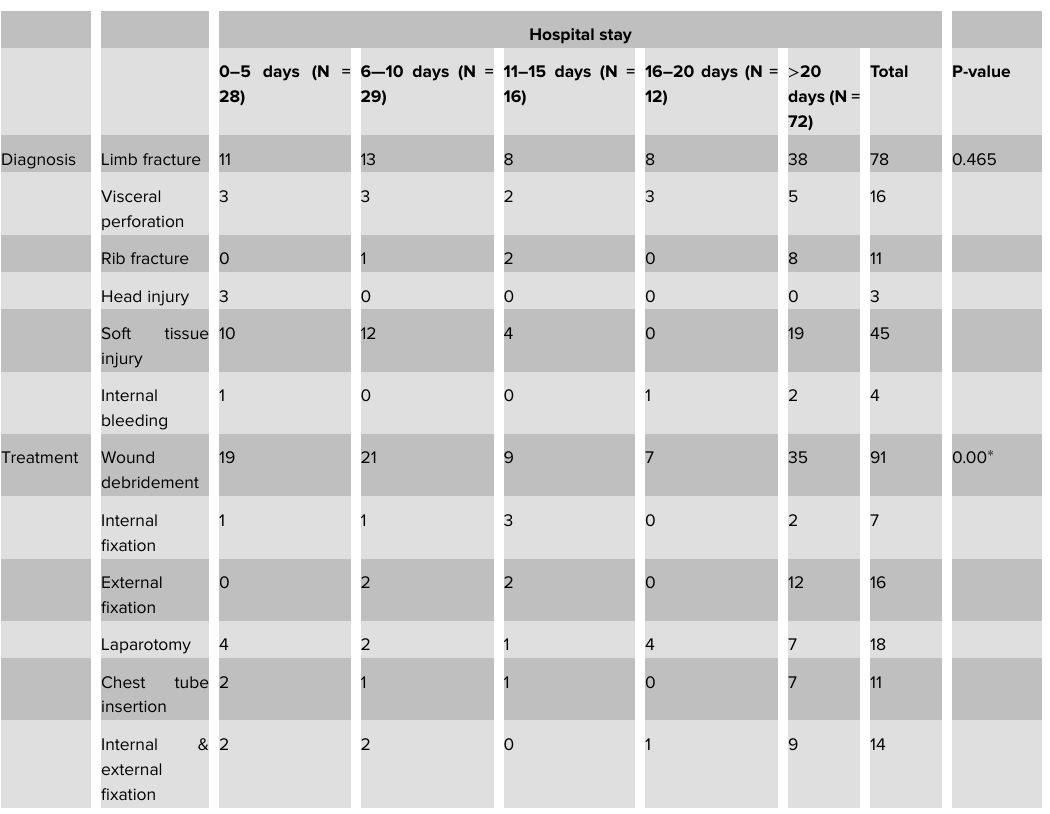
Table 3: Hospital stay related to diagnosis and